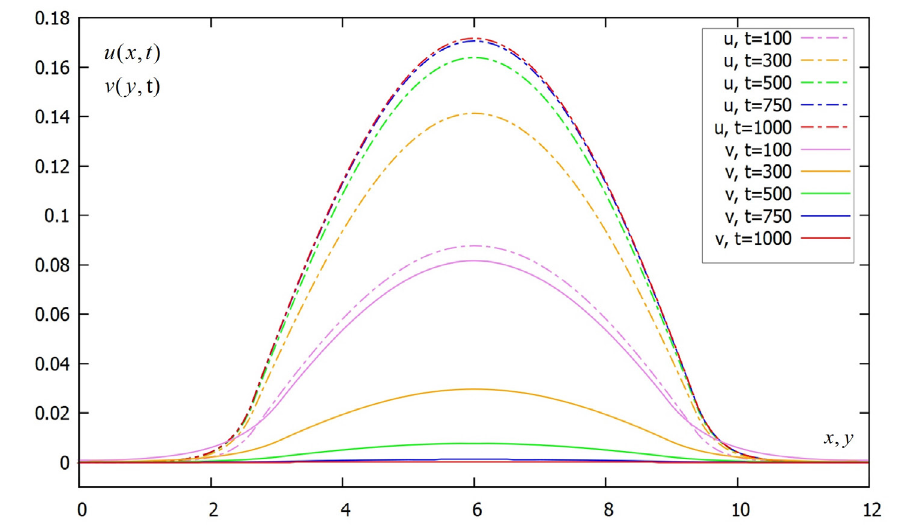
Figure 3. Solution u ( x , t ) and v ( y, t ) of system (1) in numerical